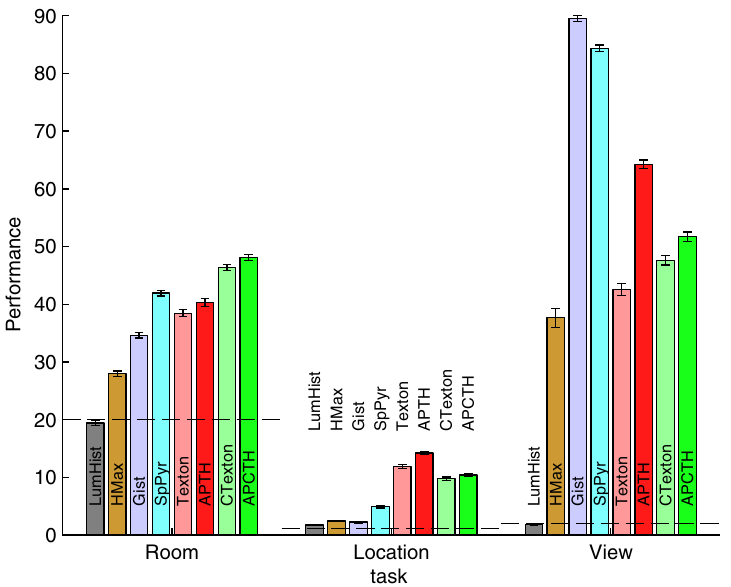
Figure 3 . Classi fi cation performance of room, location, and view classi fi cation task in PC by feature vector. Dashed lines mark chance levels. APTH: Adaptive partitioning of texture histograms. APCTH: Adaptive partitioning of color texture histograms. SpPyr: Spatial Pyramids. LumHist: Luminance histogram. CTexton: Colored